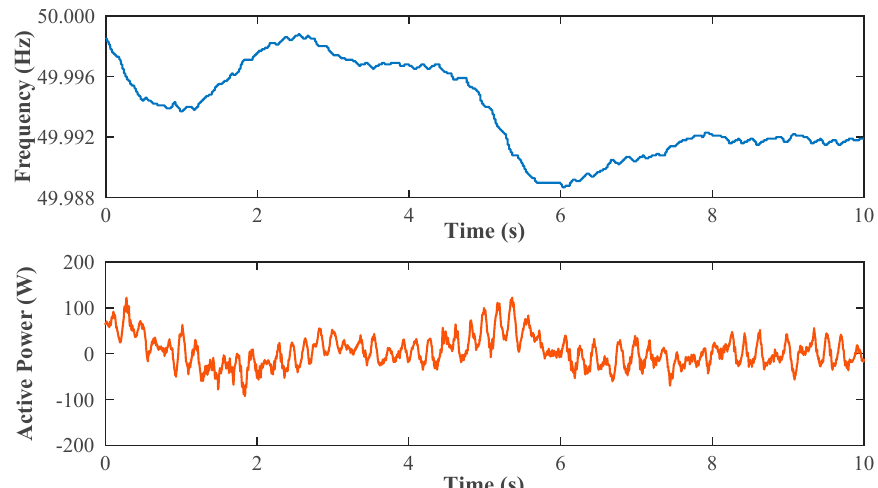
Figure 9. Frequency measurement at a HV bus of the Greek power system (upper). Electrical power of an unloaded PV system equipped with supercapacitor able to provide inertia constant H = 9.5